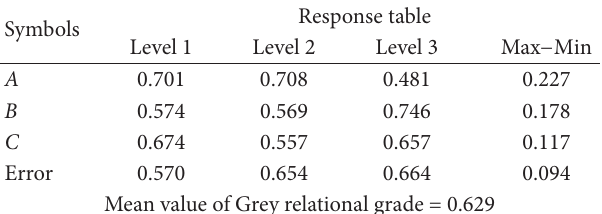
T 8: Response table for Grey relational